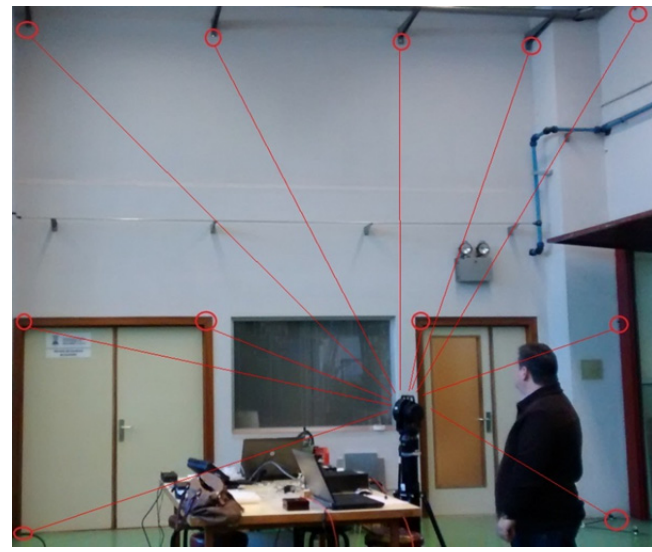
Figure 7. Reflector positions of the calibration procedure.